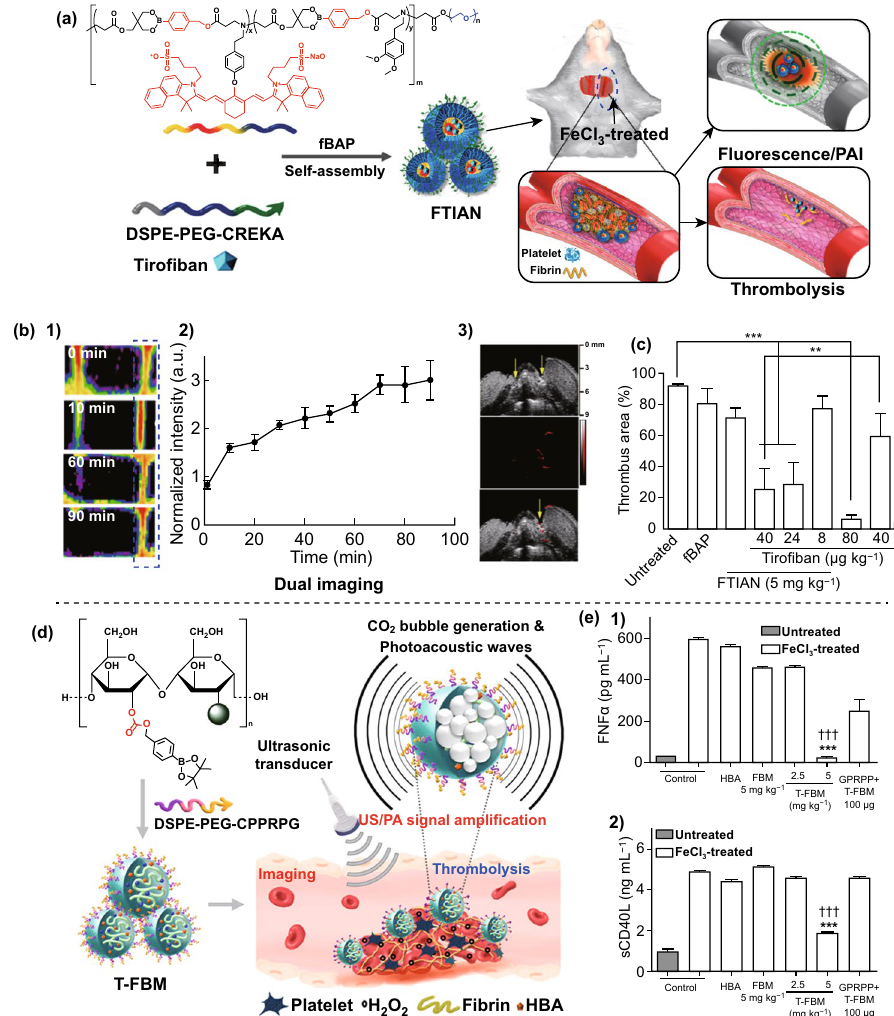
Fig. 5 a Preparation diagram of FTIAN, and its application in H 2 O 2 -responsive thrombolysis. b Fluorescence imaging ( 1 ) and fluorescence intensity ( 2 ) of the thrombotic model after the FTIAN administration; the US/PAI of the thrombotic model after the FTIAN administration ( 3 ). c The relative thrombus size after different treatments [79]. Copyright 2017 American Chemical Society. d Preparation diagram of T-FBM nano- particle, and its application in H 2 O 2 -triggered thrombolysis. e The expression of TNF-α ( 1 ) and sCD40L ( 2 ) of the thrombotic model after the T-FBM administration [80]. Copyright 2018 American Chemical